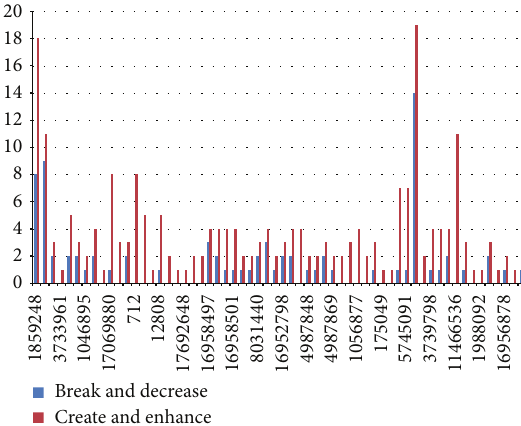
Figure 2: This chart shows the level of the increase in expression against its decrease. Here, the blue bars represent site breakage and decrease in binding efficiency of miRNAs and the red bars indicate the creation of sites and the increase in binding efficiency. The 𝑥 - axis corresponds to the number of microRNAs an SNP can target and the 𝑦 -axis shows the specific SNP id concerned. In this chart, we can see underexpression of genes because of the higher levels of creation and enhancement.